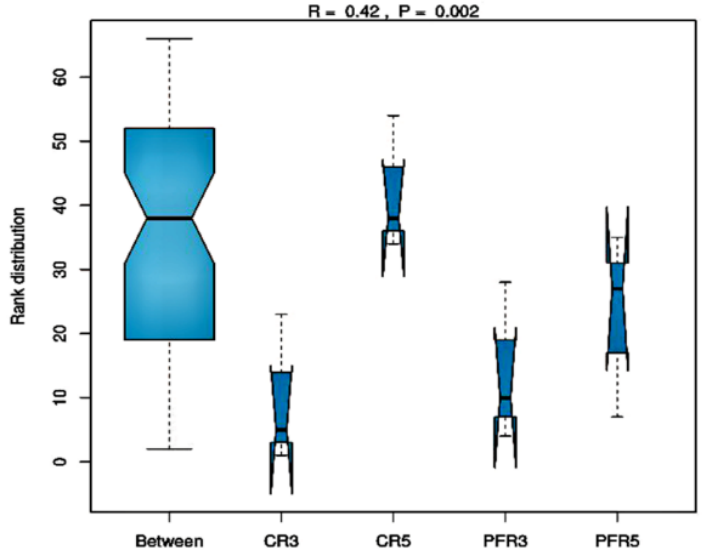
Figure 4. Box-and-whisker plots visualizing the results of the analysis of similarity (ANOSIM) to estimate fungal communities associated with calyx-end and peel tissues of different management practices, i.e., bagging (CR5 and PFR5) and non-bagging (CR3 and PFR3). In the plot, the y -axis represents the distant rank between samples, and the x -axis represents the results among samples.